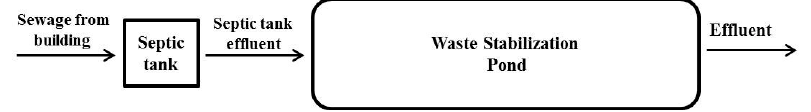
Figure 2. Layout of septic tank–waste stabilization pond system for the treatment of wastewater from a residential building.